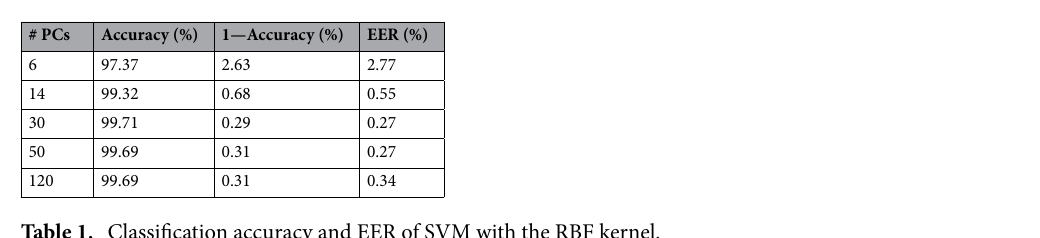
Table 1. Classification accuracy and EER of SVM with the RBF